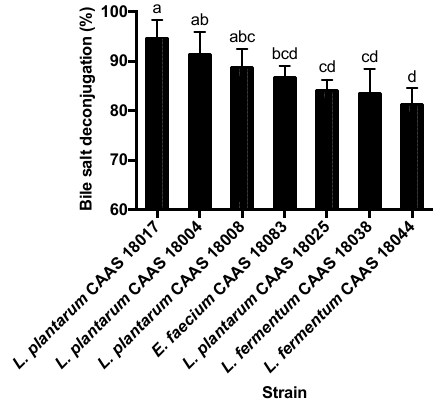
Figure 3. Comparison of lactic acid bacterial strains for bile salt deconjugation ability. Data are represented as the mean ± SD ( n = 3). Means not sharing a common letter differ significantly from each other ( p < 0.05).